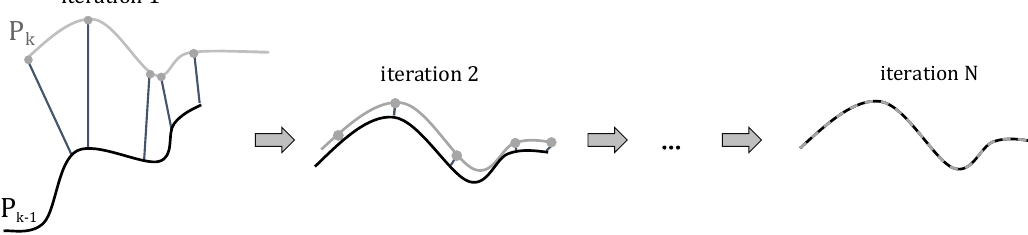
Figure 10. Graphical representation of the ICP algorithm. In every iteration, four main steps are conducted: (1) point selection; (2) correspondence estimation; (3) weighting; and (4)